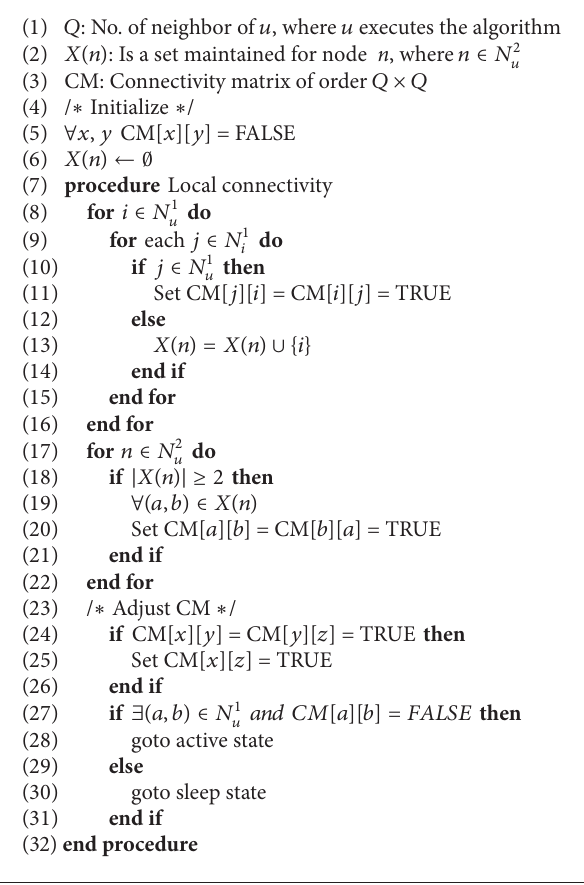
Algorithm 1: Sleep eligibility algorithm.